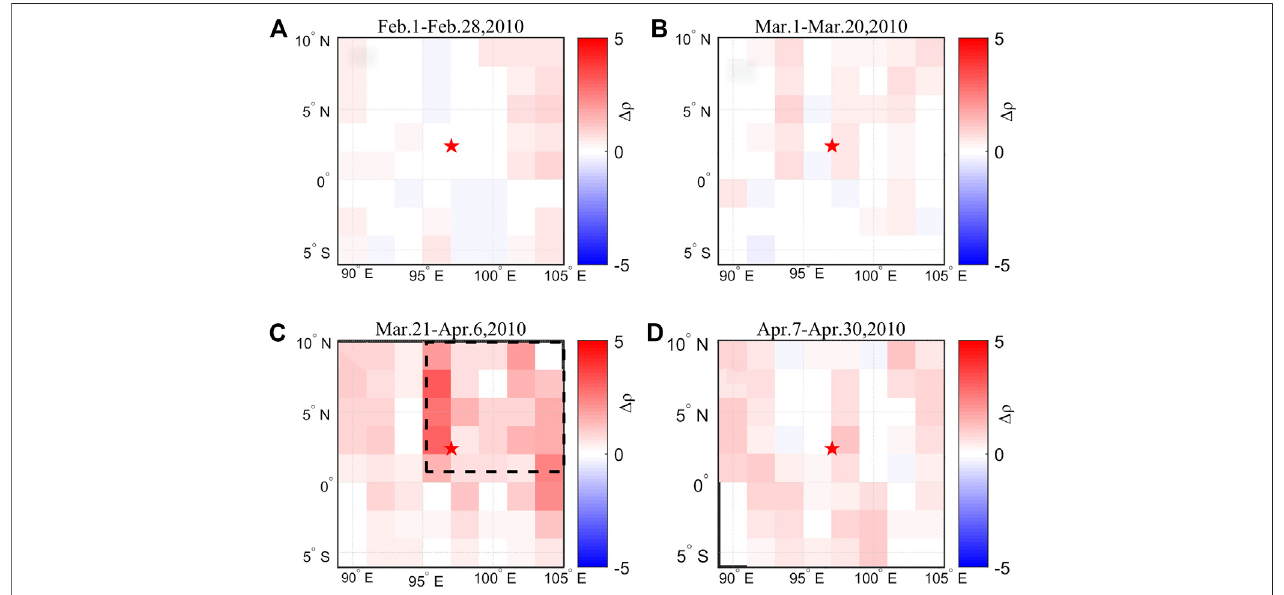
FIGURE 5 | The Δ ρ distribution over the epicenter area computed by power spectral density values of magnetic fi eld at frequency (468 – 566 Hz) during the 2010 Mw 7.8 Sumatra earthquake; (A) February 2 to February 28, 2010; (B) March 1 to March 20, 2010; (C) March 21 to April 6, 2010; (D) from April 7 to April 30, 2010. The star represents the2010Mw7.8Sumatraepicenter,the Δ ρ means theperturbation amplitude ofcurrenttime intervals(a, b,c,d)relative tothebackgroundmap builtby observations from 2008 to 2010 (see text for explanation). The black dashed rectangle denotes the a wide scope area of power spectral density values ’ enhancement.